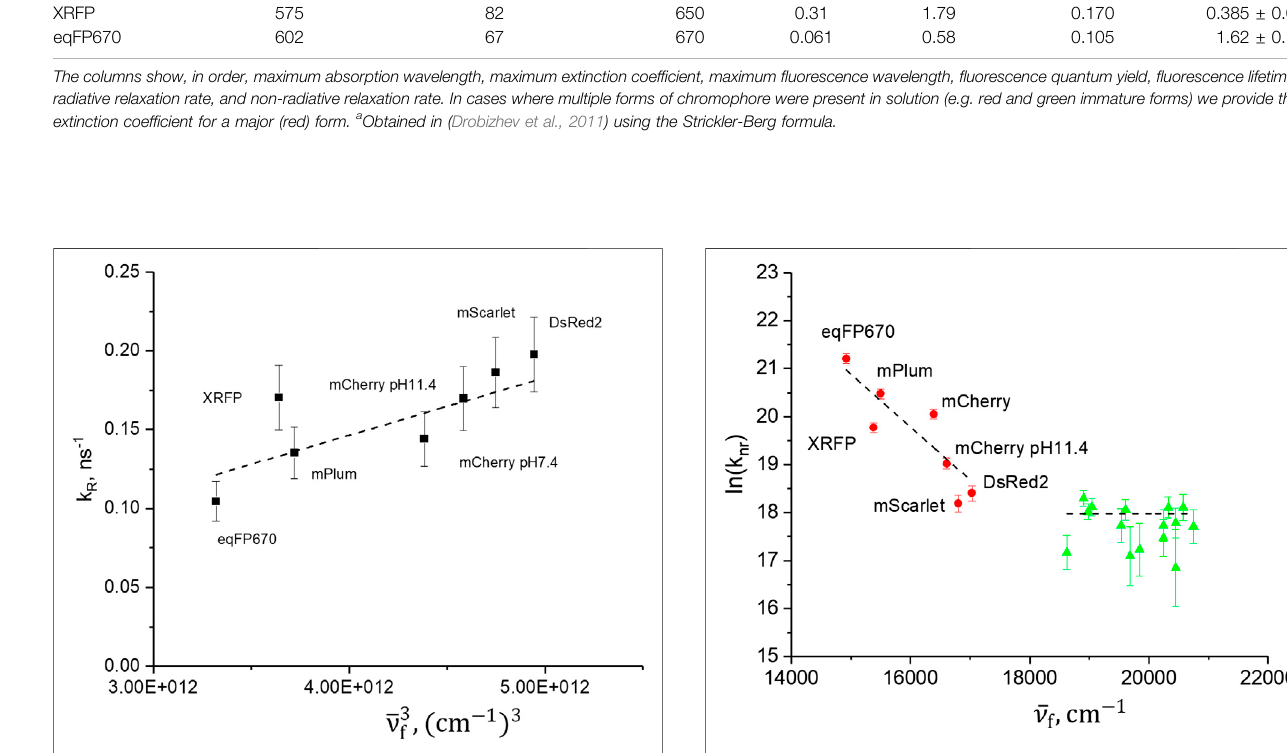
FIGURE 2 | Dependence of radiative relaxation rate on cube of maximum fl uorescence frequency. Dashed line represents the best fi t to the Einstein equation for spontaneous emission rate.